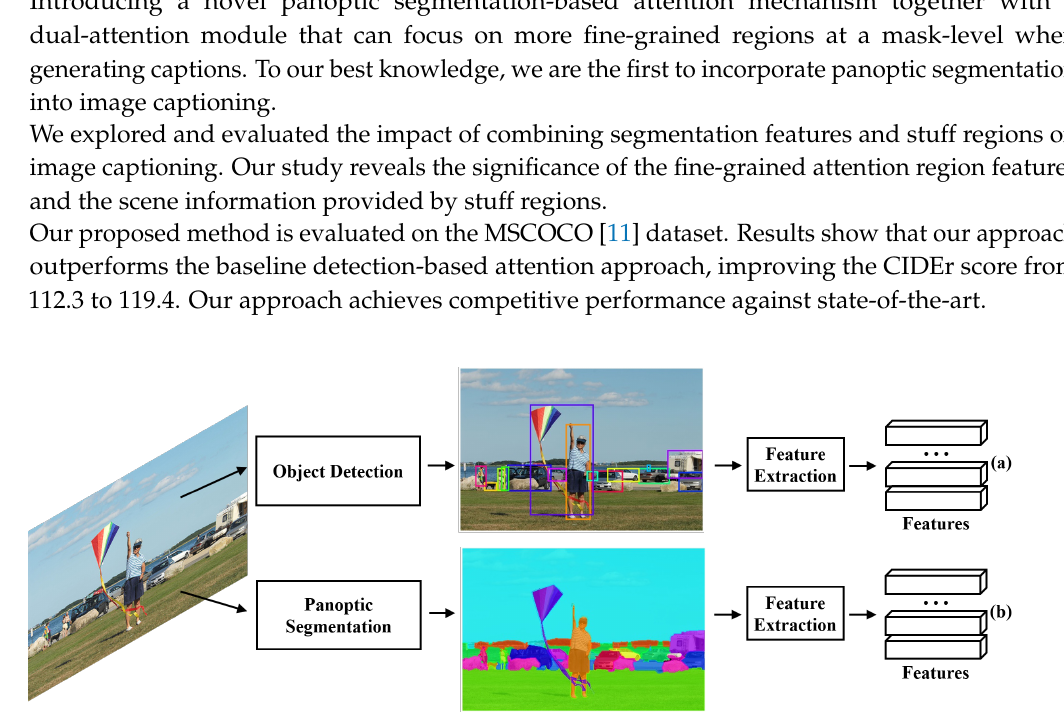
Figure 2. Comparison of the feature extraction procedures between a detection-based attention model and our panoptic segmentation-based attention model: ( a ) The feature extraction procedure of the detection-based attention model. The attention regions are the rectangular regions annotated with colored edges. ( b ) The feature extraction procedure of our panoptic segmentation-based attention model. The attention regions are the fine-grained regions annotated in the colored map. With panoptic segmentation, our method can not only generate fine-grained attention regions, which avoids the negative impact caused by irrelevant regions, but also performs attention to stuff class